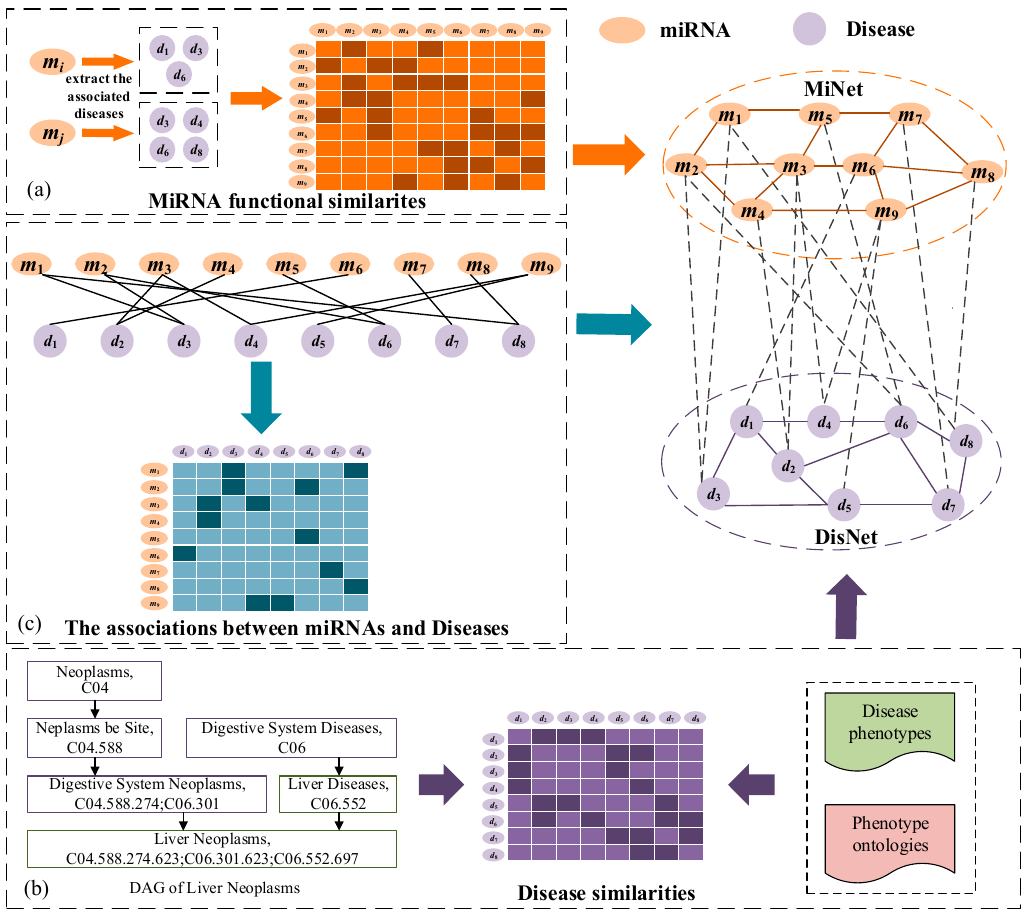
Figure 1. Construction and representation of a microRNA (miRNA)-disease heterogeneous network. ( a ) Calculate the miRNA similarity based on diseases associated with two miRNAs. ( b ) Construct the disease similarity by combining their disease phenotypes and phenotype ontologies. ( c ) Add edges between miRNAs and diseases.